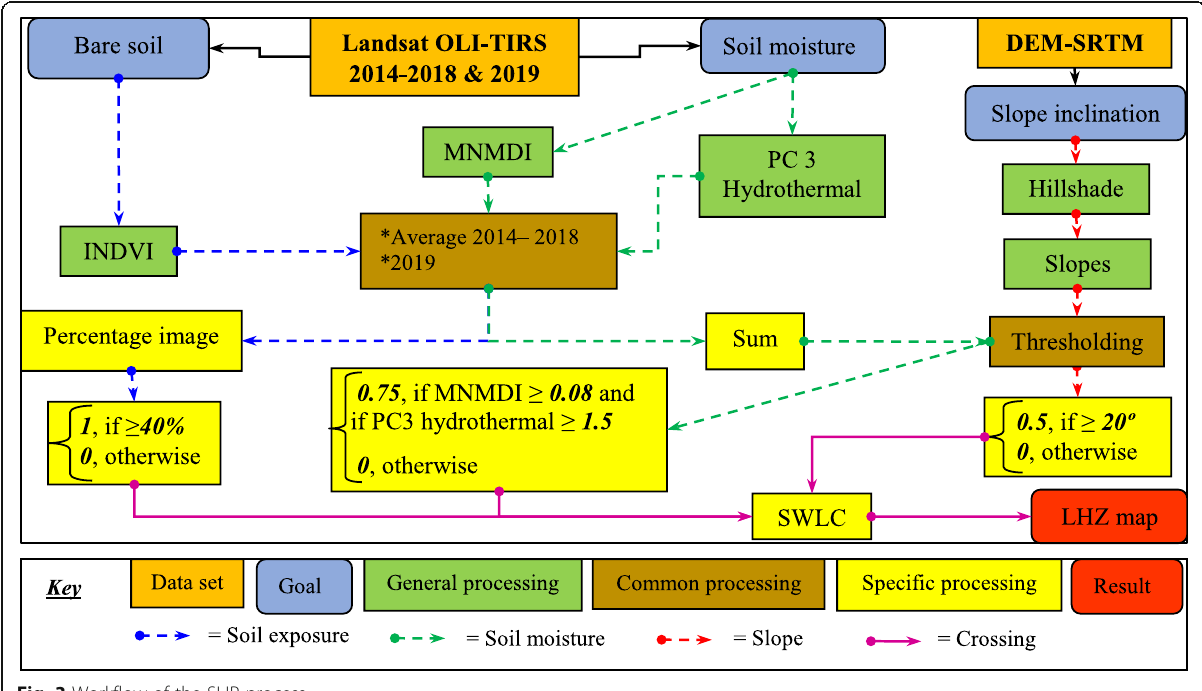
Fig. 3 Workflow of the SLIP